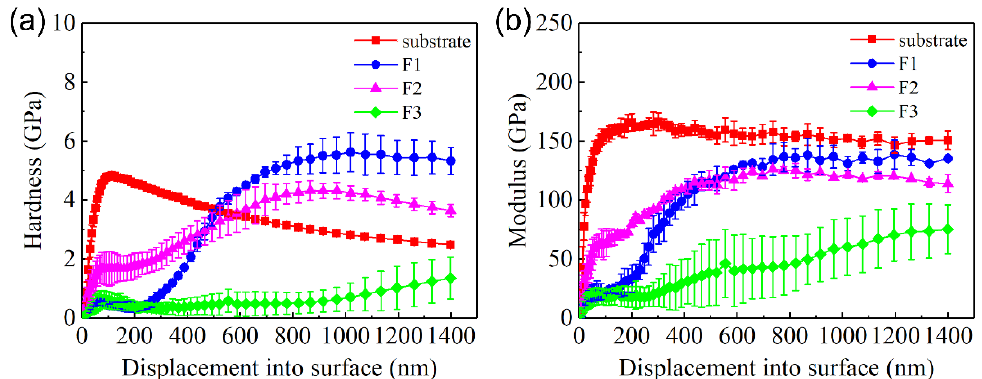
Figure 4. Surface hardness and elastic modulus of the Cu substrate and three films after plasma nitriding at 650 °C for 4 h with increasing displacement: ( a ) hardness, ( b ) elastic modulus.